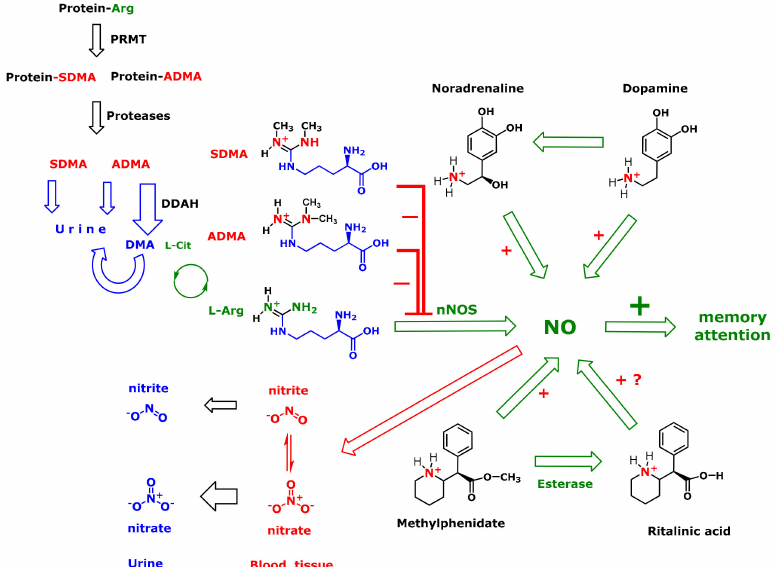
Figure 1. Simplified schematic of the L-arginine / nitric oxide pathway in the attention deficit hyperactivity disorder, its interaction with methylphenidate, and possible e ff ects on memory and attention. The symbol − means inhibition, reduction, or attenuation. The symbol + means activation or enhancement. For more details see the text. ADMA, Asymmetric dimethylarginine; Arg, Arginine; DDAH, Dimethylarginine dimethylaminohydrolase; DMA, Dimethylamine; L-Cit, L-Citrulline; NO, Nitric Oxide; nNOS, Neuronal nitric oxide synthase; PRMT, Protein arginine methyltransferase; SDMA, Symmetric